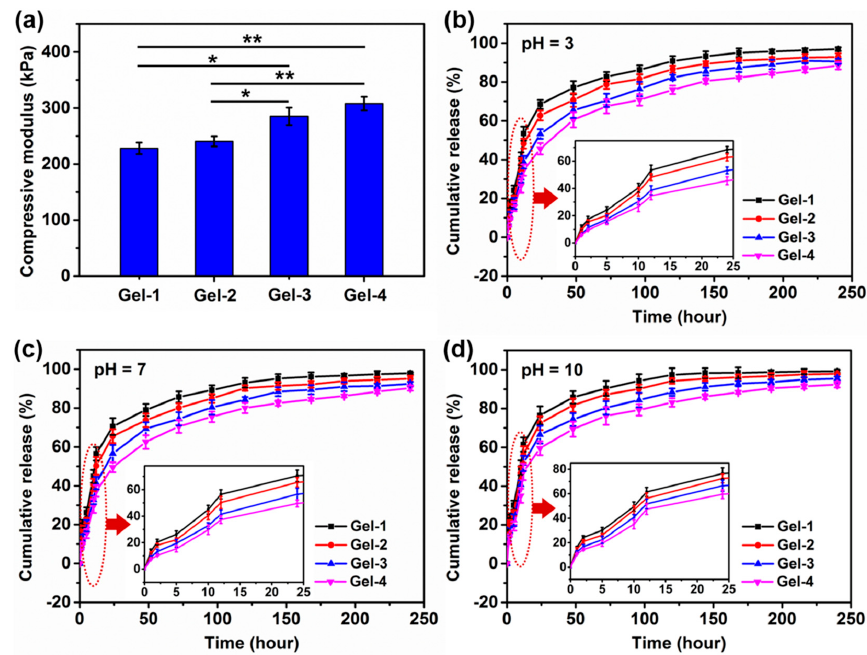
Figure 7. ( a ) Compression modulus of Gel-1, Gel-2, Gel-3 and Gel-4 in a neutral environment. Controlled release of triclosan from the hydrogels in various environments as a function of time: ( b ) pH = 3; ( c ) pH = 7; ( d ) pH = 10. Insets showed magnifying drug release profile in 25 h. *